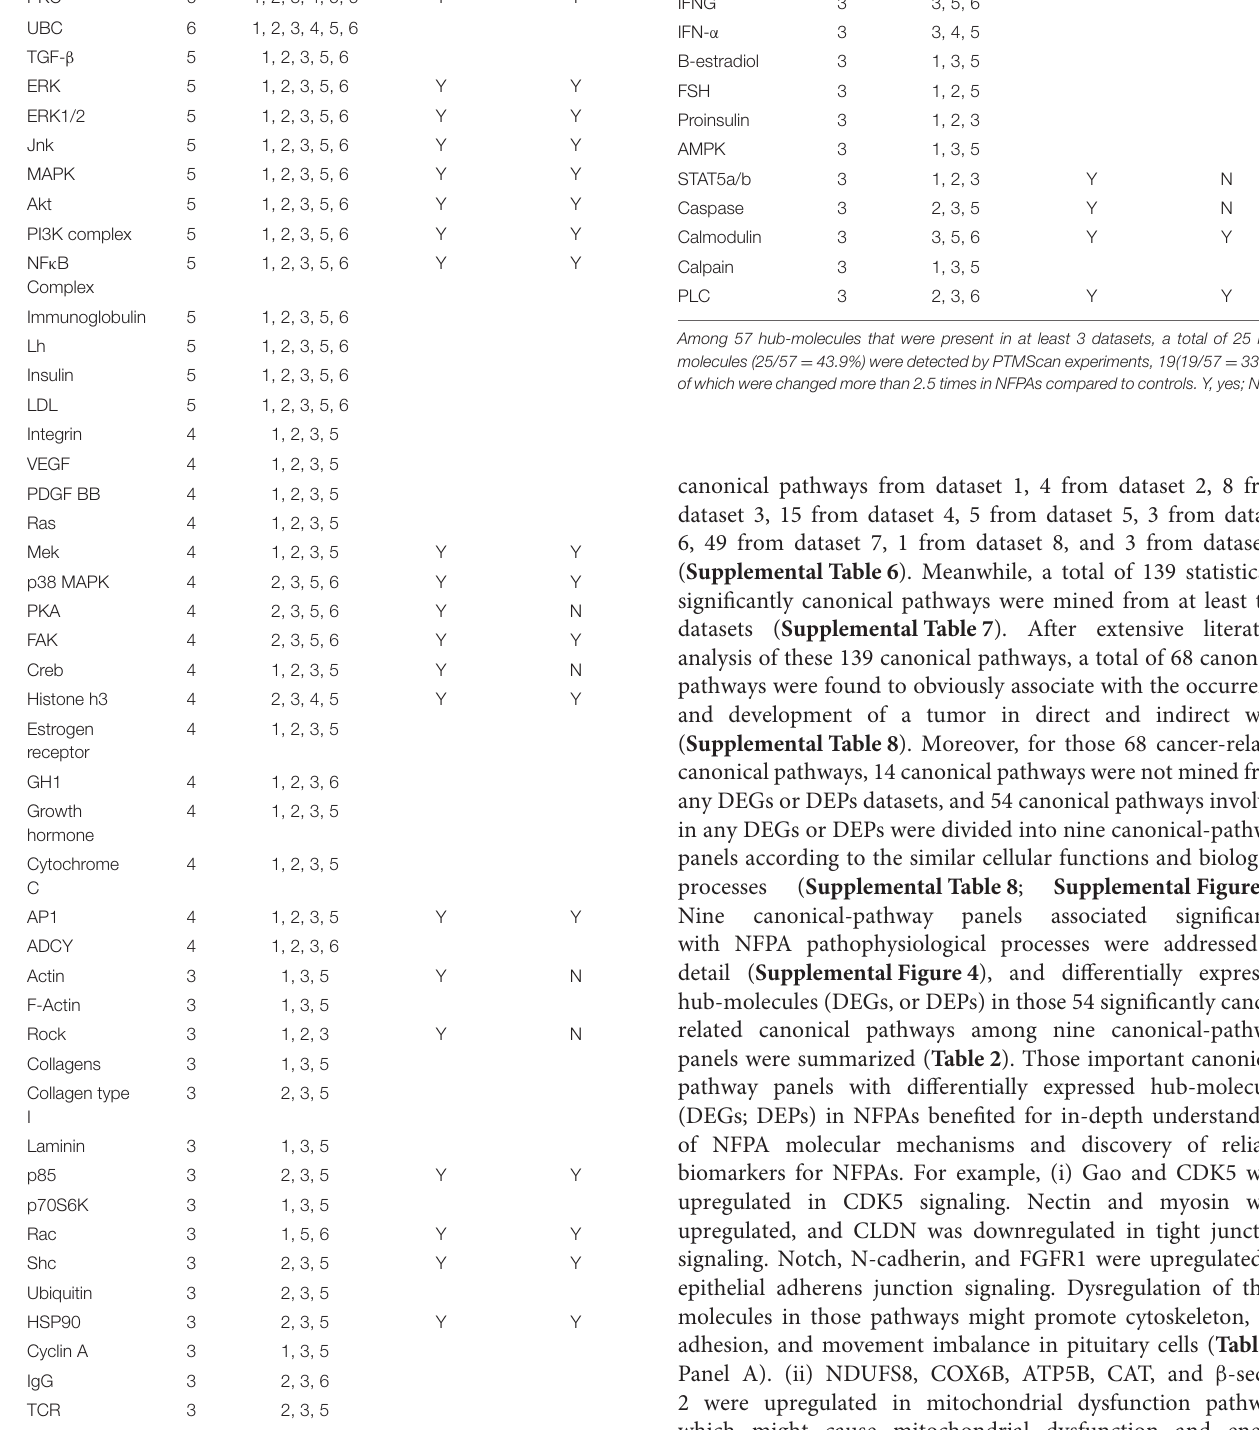
TABLE 1 | High-frequency hub-molecules that were present in multiple datasets of NFPA group. Hub Frequency Dataset serial PTMScan molecule number